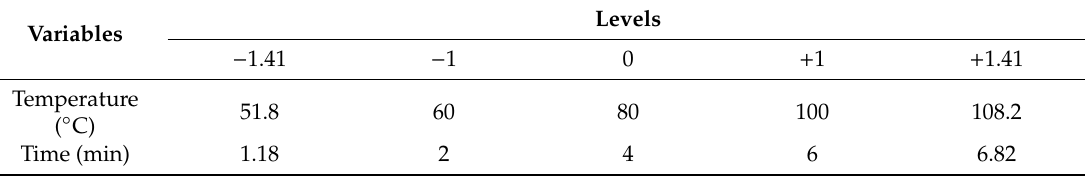
Table 5. Independent variables of the experimental design and the extraction conditions. Variables